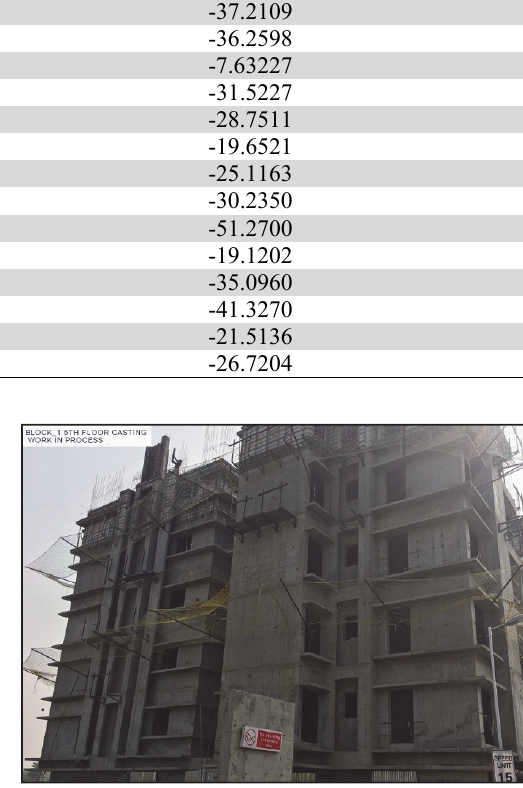
Fig. 2. The top-ranked under-construction housing